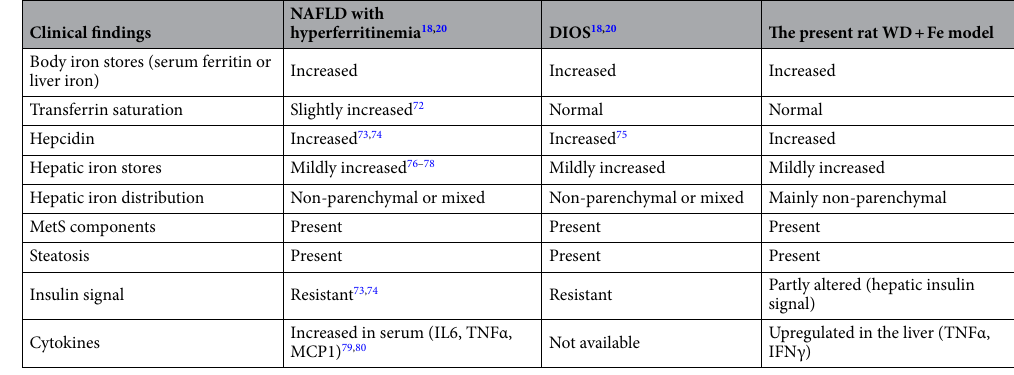
Table 1. Comparison of clinical features of NAFLD with hyperferritinemia, DIOS and this